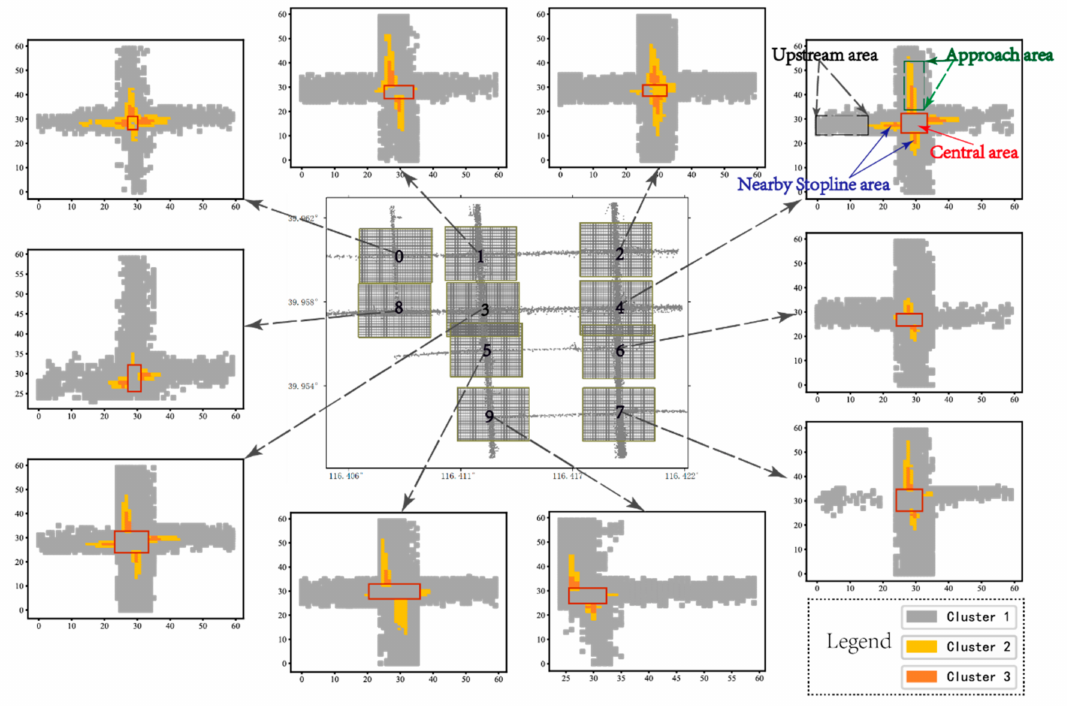
Figure 4. Identified the intersection